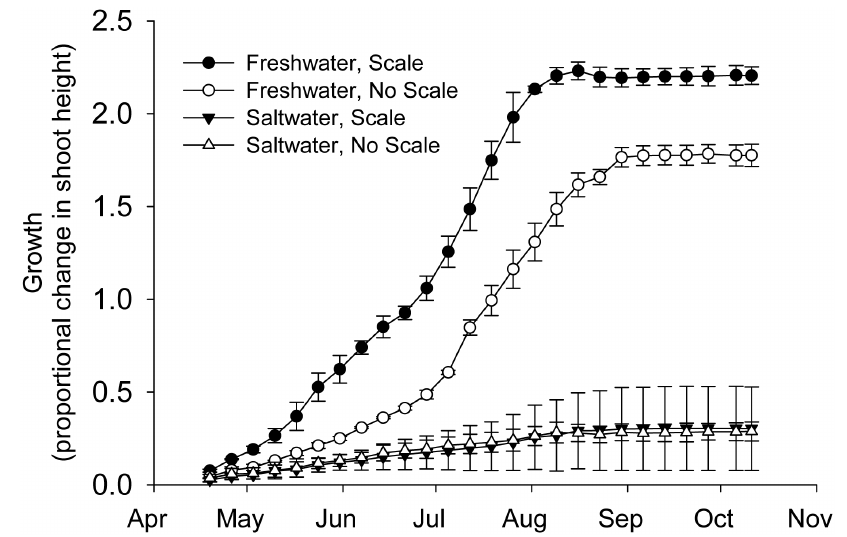
Figure 3. Effects of scales and reduced salinity on Spartina growth during the 2011 mesocosm experiment. Growth is reported as the proportional change in shoot height. Overcompensation to scale herbivory in freshwater treatments was absent in saltwater treatments. N=7–8. Values are means 6 SE.